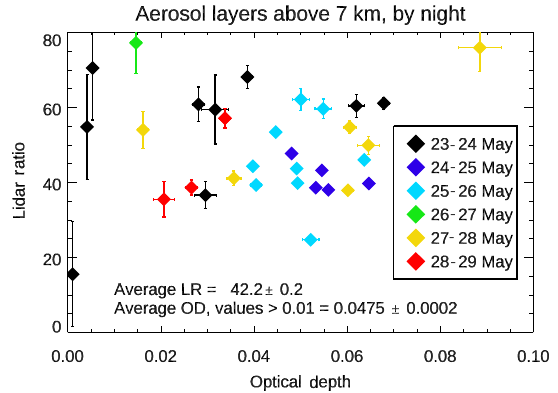
Figure 8. Lidar ratio plotted against total aerosol optical depth measured above 7km by the Met Office Raman lidars on different nights.